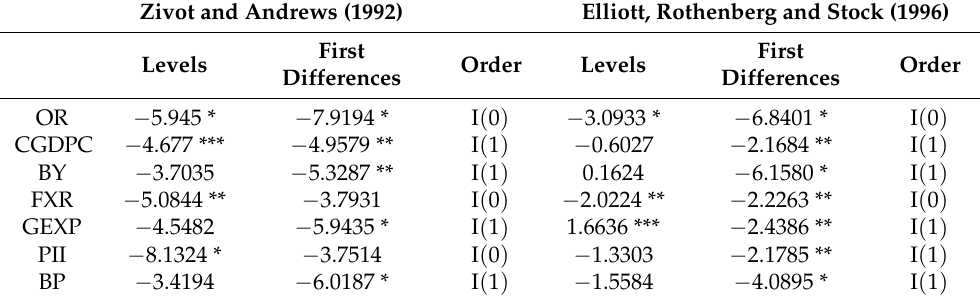
Table 1. Tests for stationarity. Zivot and Andrews (1992) Elliott, Rothenberg and Stock